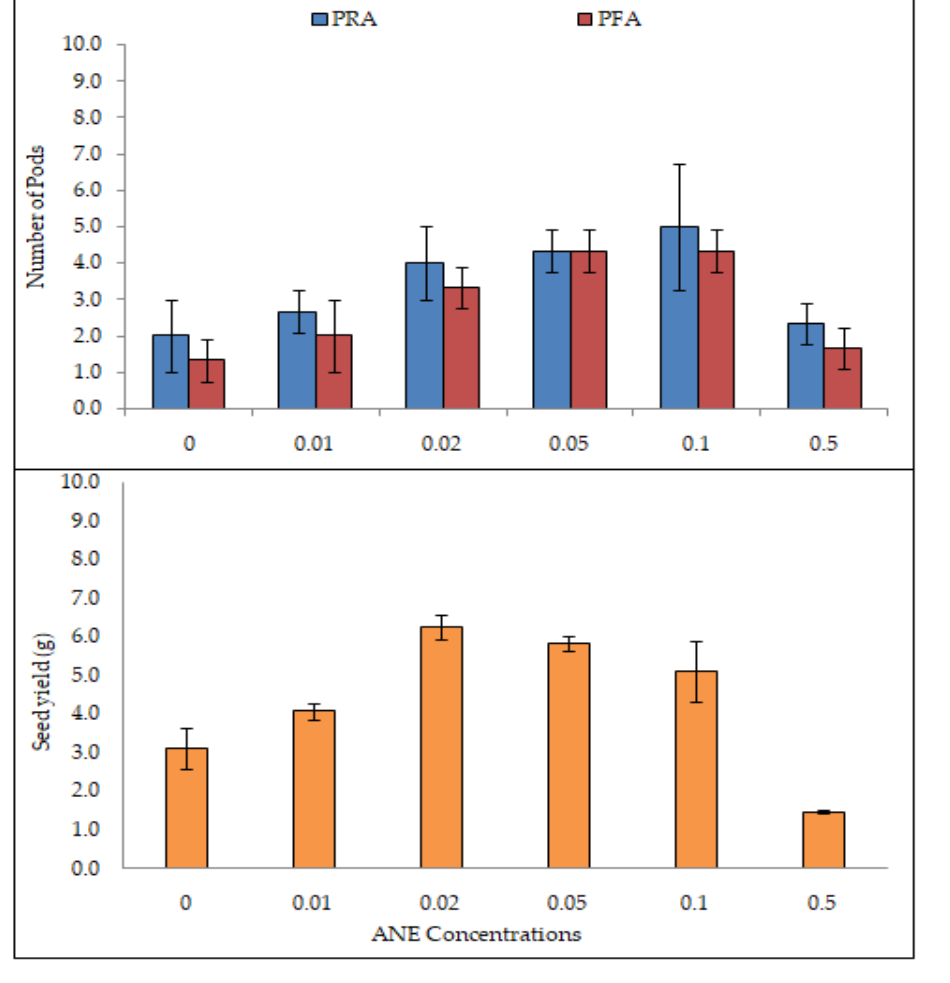
Figure 6. Efficacy of ANE treatments in root application on yield of seeds of V. aconitifolia. Bar indicates mean ± SD (n = 3). The chlorophyll a was 0.10 ± 0.001 mg in PFA (ANOVA; F = 21560.3; p < 0.01) and 0.19 ± 0.001 mg (ANOVA; F = 688,291; p < 0.01) in PRA; the chlorophyll b was 0.11 ± 0.002 mg in PFA (ANOVA; F = 16,084.42; p < 0.01) and 0.30 ± 0.002 mg in PRA (ANOVA; F = 226,096; p < 0.01); total chlorophyll was 0.06 ± 0.002 mg (ANOVA; F = 5602.03; p < 0.01) in PFA and 0.19 ± 0.002 mg in PRA (ANOVA; F = 117,221; p < 0.01); and the total carotenoid content was 0.7 ± 0.001 mg (ANOVA; F = 14,375.03; p < 0.01) in